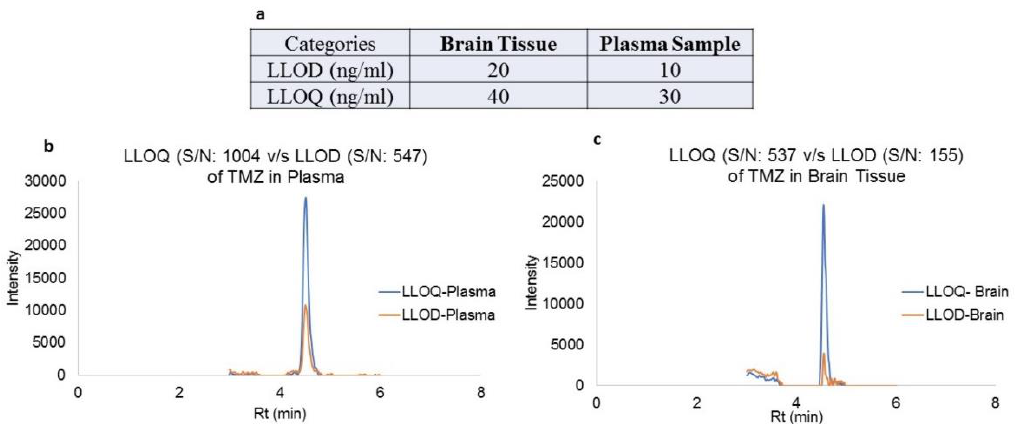
Figure 5. This method provided a simplest and effective quantitation TMZ by single ion monitoring (SIM) protocol as per standards set by FDA and ICH guidelines for bioanalytical method development. This simultaneous estimation method was used for the quantitative measurements TMZ in plasma and brain tissue of rats treated with TMZ under SPG stimulation vs. non-stimulation condition.